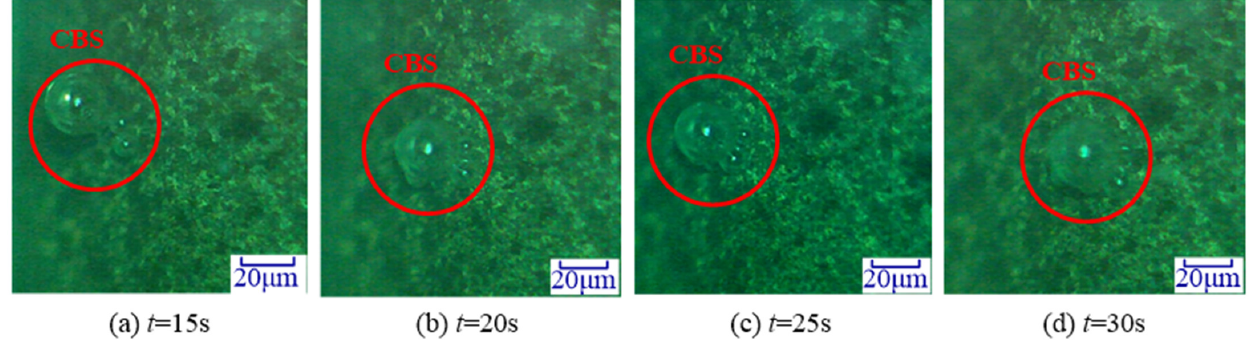
Figure 7. Cavitation on grinding wheel surface.